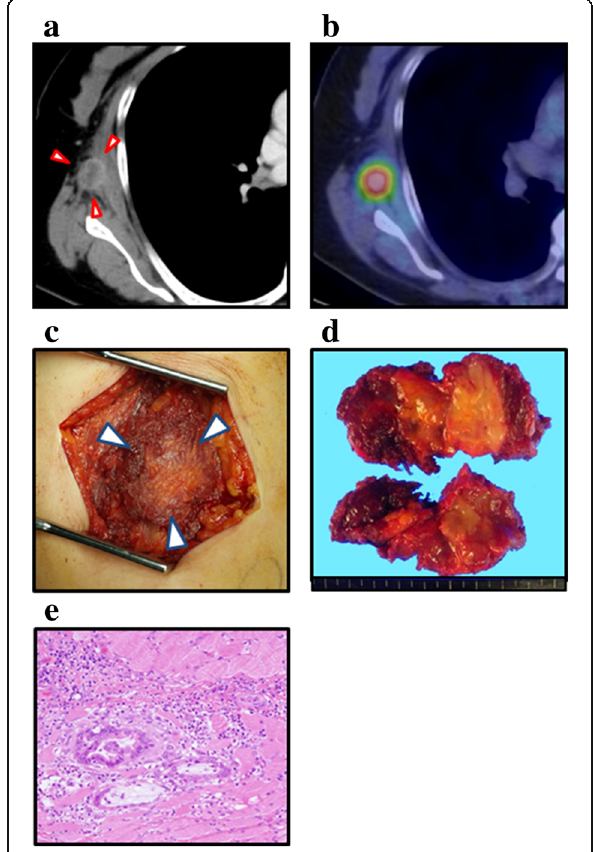
Fig. 2 An enhanced CT scan revealed an 18-mm tumor in the right thoracic wall ( a , arrowheads). PET-CT showed FDG uptake of the tumor ( b ). The tumor existed in the muscle ( c , arrowheads) and was resected ( d ). Postoperative histological examination confirmed the tumor as a muscle metastasis from the pancreatic cancer ( e , hematoxylin-eosin